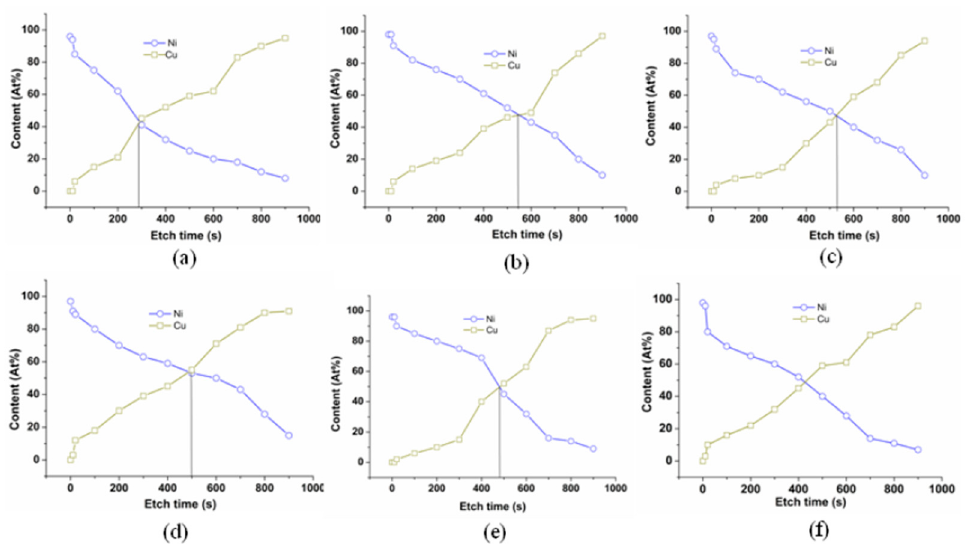
Figure 3. The element content variation curve along with the etching time: ( a ) 200 W; ( b ) 100 W; ( c ) 0 W; ( d ) 200 kHz; ( e ) 120 kHz; ( f ) 80 kHz.